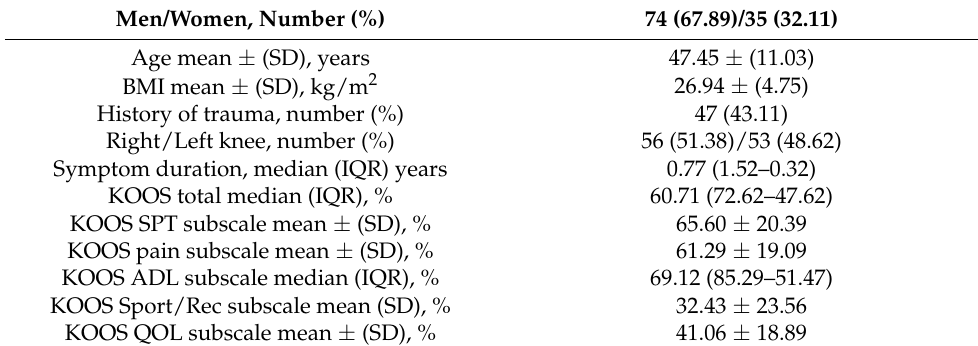
Table 1. Patient demographic and clinical characteristics at baseline (N =109).